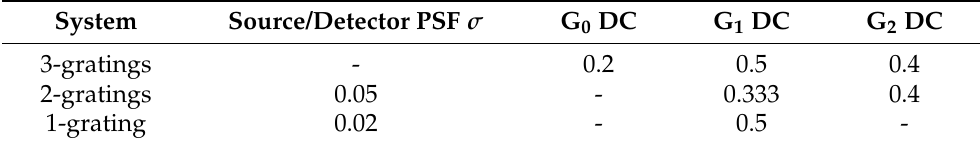
Table 1. System parameters for the three simulated systems. The source size or detector Point Spread Function (PSF) is a Gaussian and its standard deviations σ are given in multiples of the period.